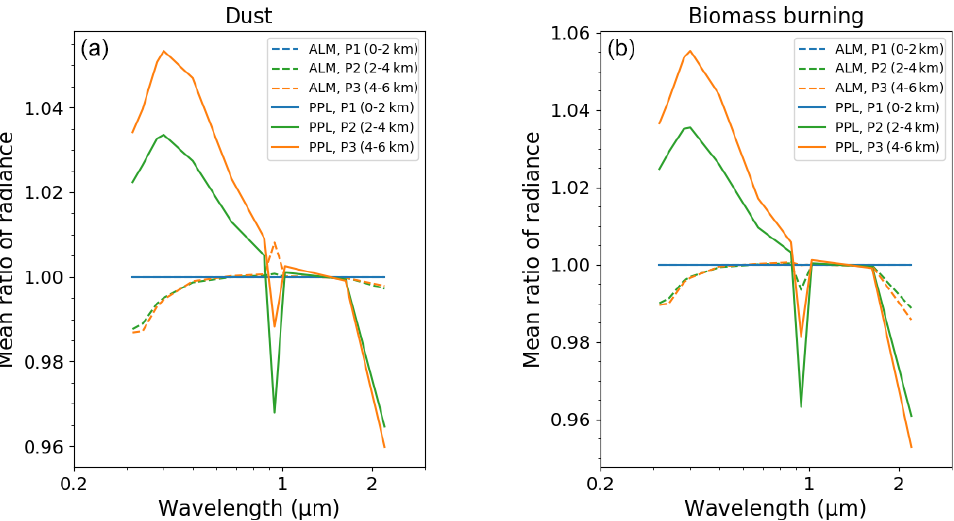
Figure 4. Mean ratio of the simulated diffuse radiances over the scattering angle with aerosol vertical profiles of 0 to 2km (blue), 2 to 4km (green), and 4 to 6km (orange) to those with the aerosol vertical profile of 0 to 2km. The left and right panels are the simulations for the dust (a) and biomass burning (b) models, respectively. The solid and dashed lines are the simulations for the almucantar (ALM) and principal plane (PPL),